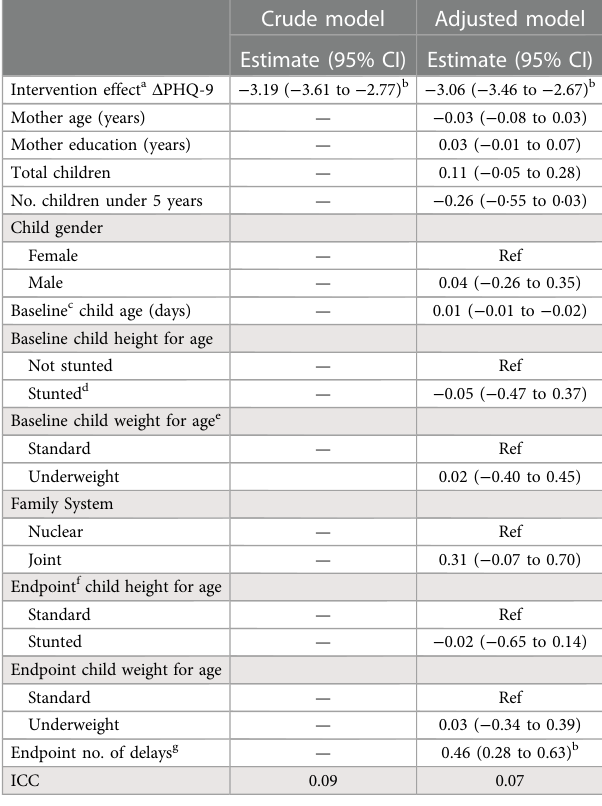
TABLE 1 Distribution of characteristics for maternal depression intervention at private clinics ( N =1,957, intervention=1,037, control= 920).